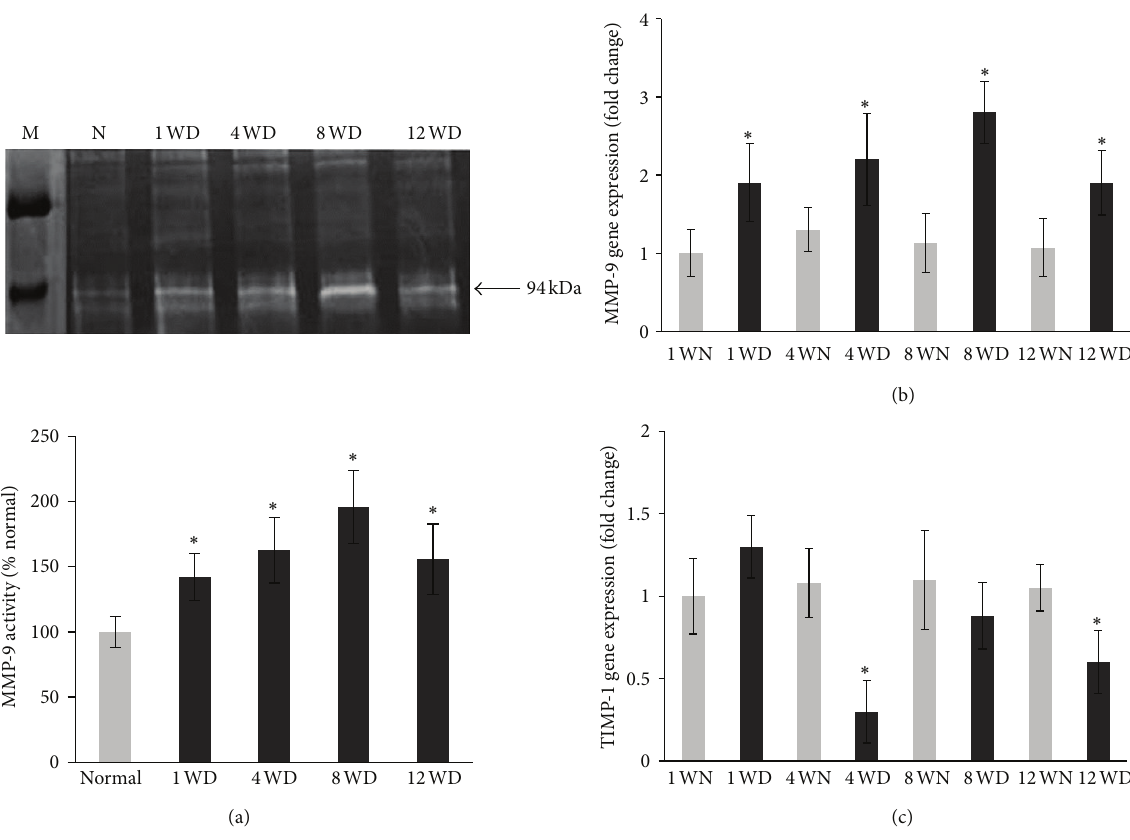
Figure1:Effectof1,4,8,and12weeksofdiabetesonretinalMMP-9andTIMP-1expression.(a)ThegelatinaselevelofMMP-9wasdetermined intheretinalhomogenatebyzymographytechnique.(b)GeneexpressionsofMMP-9and(c)TMP-1werequantifiedbyRT-PCRusingprimers given in the Materials and Methods and were adjusted to the mRNA levels of 𝛽 -actin in each sample. Each measurement was performed at least three times. Results are expressed as mean ± s.d. of at least six rats in each group. ∗ 𝑃 < 0.05 compared with normal rats. M = molecular weight marker; 1WN, 4 WN, 8WN, and 12WN = 1 week normal, 4 weeks normal, 8 weeks normal, and 12 weeks normal rat; 1WD,